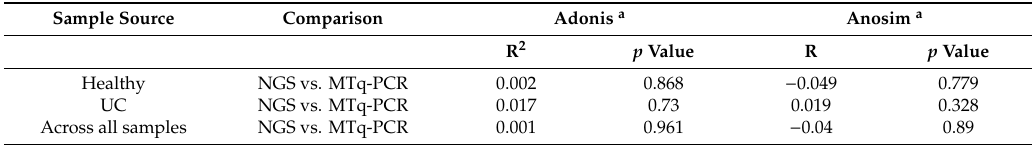
Figure 5. Principal coordinate analysis of (PCoA) of the three dominant phyla in the fecal samples of UC patients and healthy volunteers using NGS and MTq–PCR. Table 7. Adonis and Anosim statistical analyses between NGS and MTq-PCR using fecal samples collected from healthy subjects and UC patients.